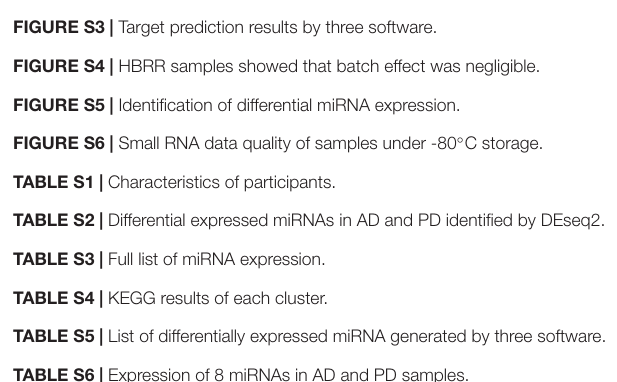
FIGURE S1 | Heatmap of the miRNA expression in AD, PD, and NC. FIGURE S2 | Seven miRNAs consistently altered in both AD and PD. FIGURE S3 | Target prediction results by three software. FIGURE S4 | HBRR samples showed that batch effect was negligible. FIGURE S5 | Identification of differential miRNA expression. FIGURE S6 | Small RNA data quality of samples under -80 ◦ C storage. TABLE S1 | Characteristics of participants. TABLE S2 | Differential expressed miRNAs in AD and PD identified by DEseq2. TABLE S3 | Full list of miRNA expression. TABLE S4 | KEGG results of each cluster. TABLE S5 | List of differentially expressed miRNA generated by three software. TABLE S6 | Expression of 8 miRNAs in AD and PD